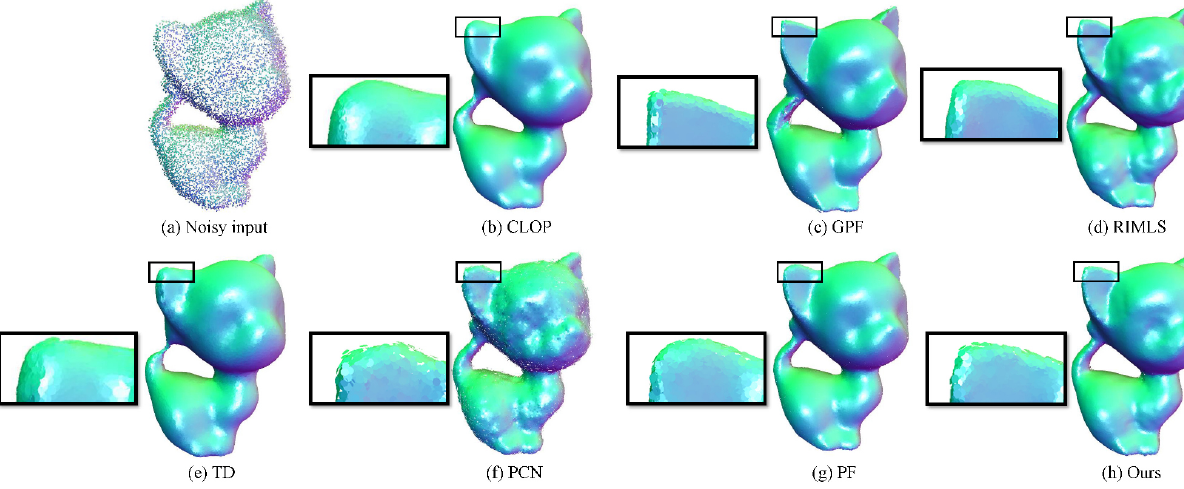
Fig. 8 Upsampling results on Kitten corrupted with 1.0% synthetic